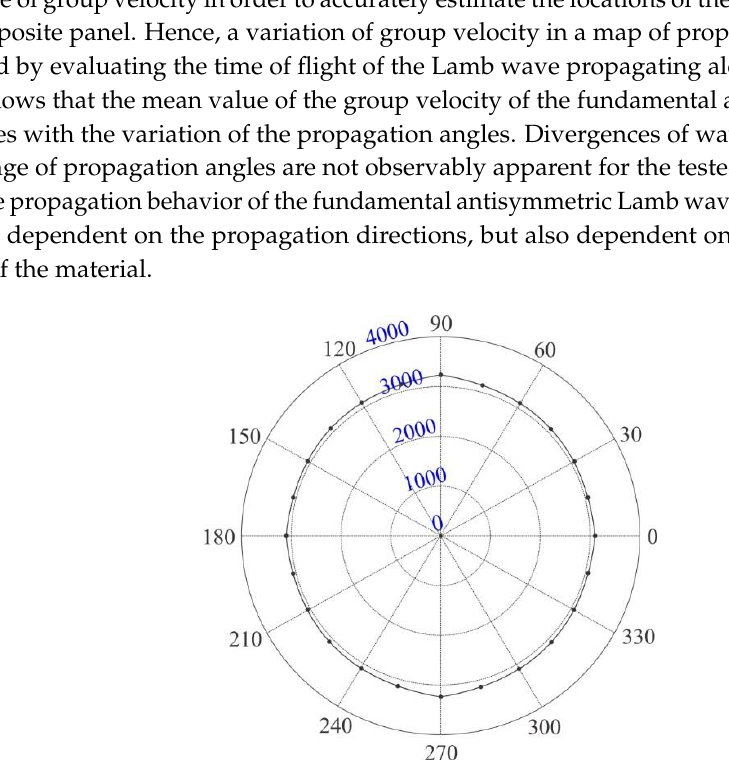
Figure 6. A map of group velocity variations depending on the propagation angles.